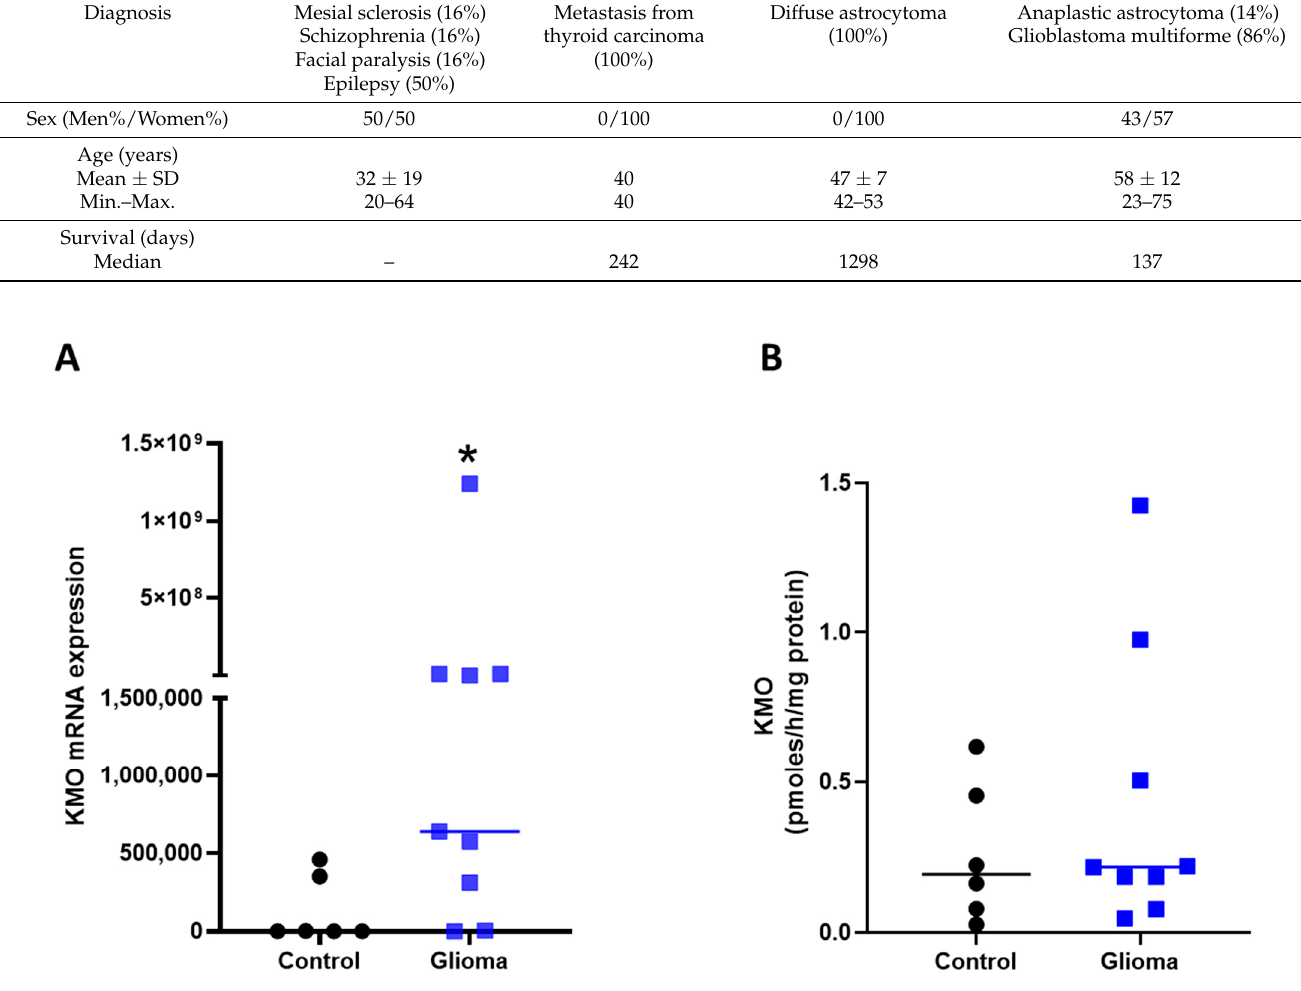
Figure 3. Kynurenine monooxygenase in GBM tissue. ( A ) KMO mRNA copy number in tissue samples: patients diagnosed with a neurological disease (control, n = 6) versus patients diagnosed with grade II to IV astrocytoma (glioma, n = 9). ( B ) Determination of KMO activity by quantification of 3-HK levels after 2 h incubation of the same samples used for KMO expression. Data are shown with the median (horizontal line); * p < 0.05 based on the Mann–Whitney test.